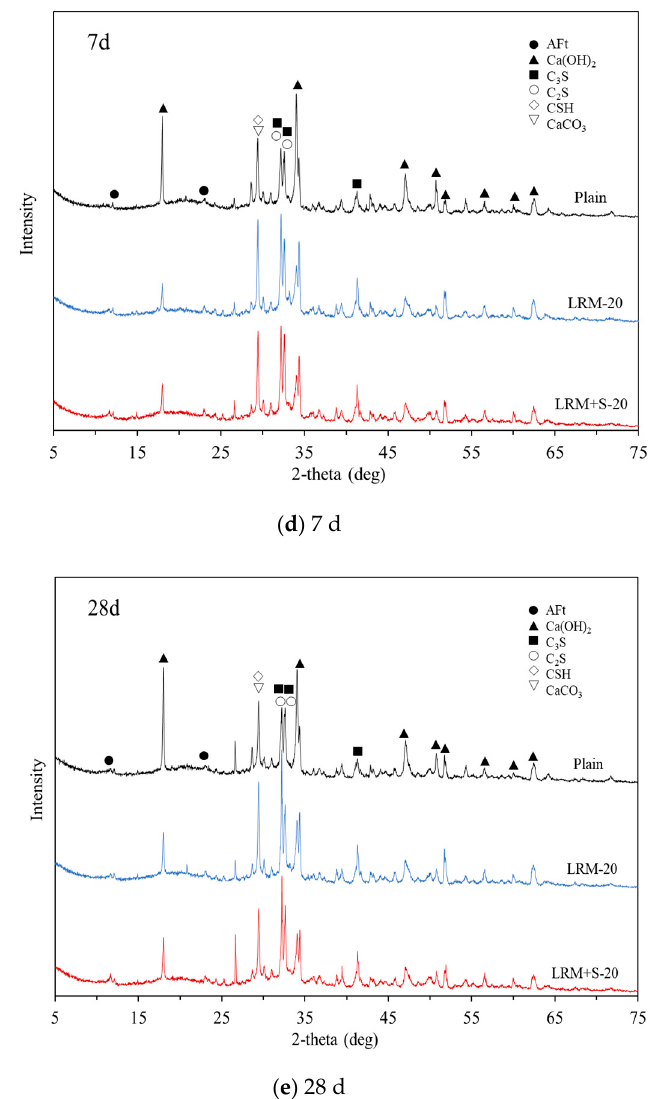
Figure 7. XRD spectrum results of the mixtures with red mud at varying ages.